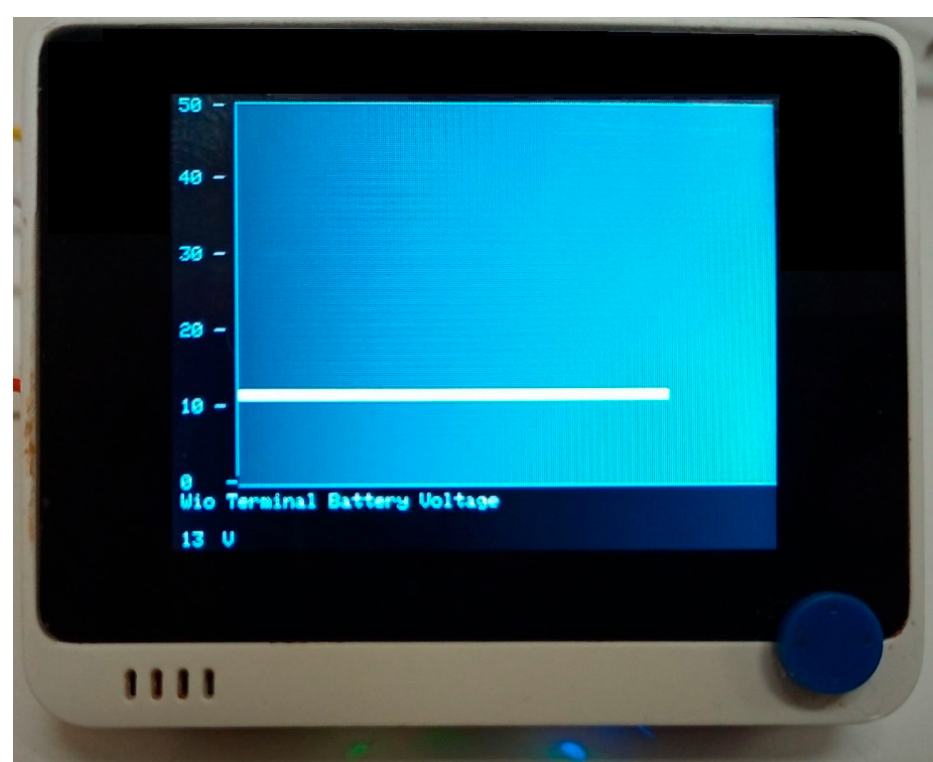
Figure 13. Node - Red dashboard for visualization.